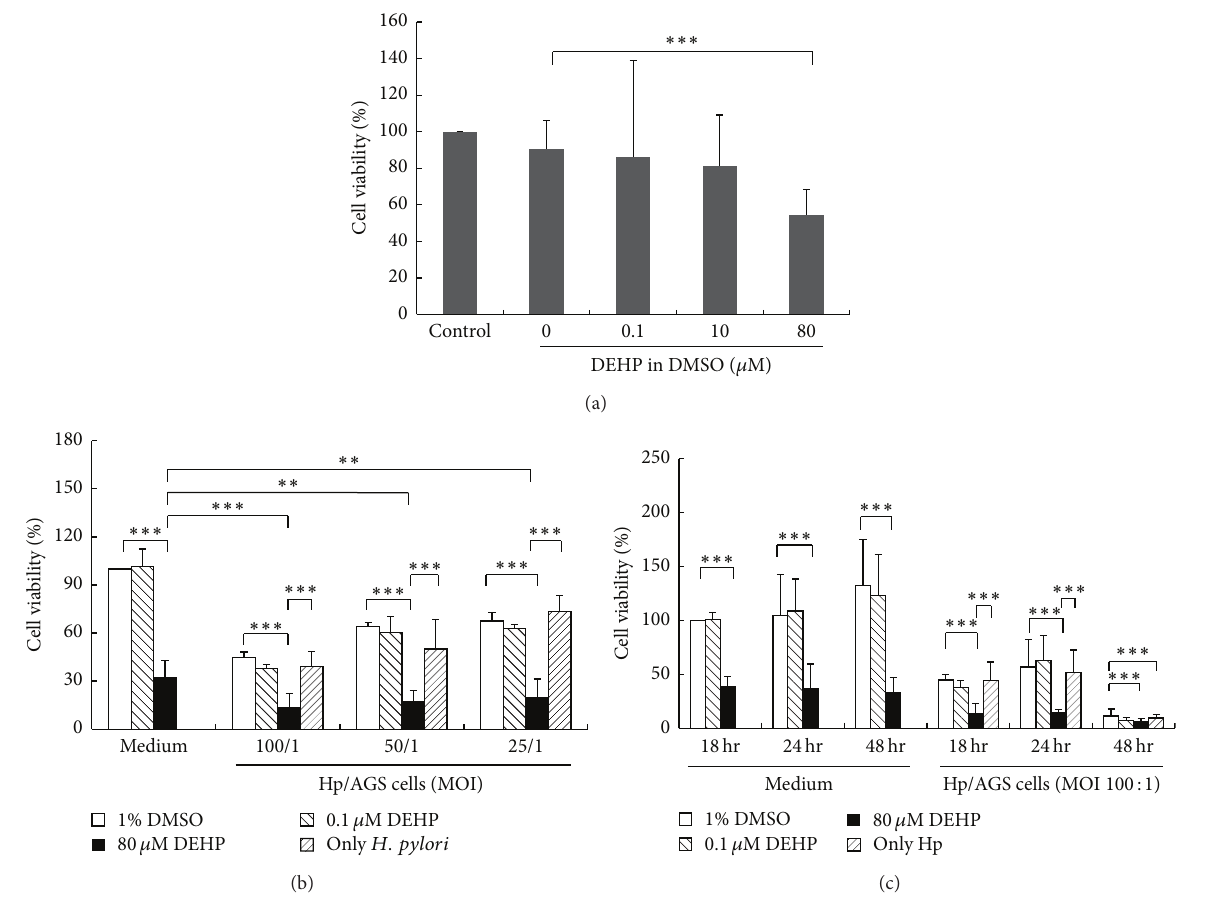
Figure 1: The cell viability of AGS cell. (a) Cells were treated with 0.1 to 80 𝜇 M DEHP for 24 hours. (b) Cells were treated 0.1 and 80 𝜇 M DEHP alone or combined with H. pylori (MOI = 100:1 ∼ 25:1) for 18 hours (ten independent experiments). (c) Cells were treated 0.1 and 80 𝜇 M DEHP alone or combined with H. pylori (MOI = 100:1) for 18, 24, and 48 hours Values obtained from MTT assay in mean + SD and normalized to nontreated value ( 𝑁 = 7 , three independent experiments, ∗∗ 𝑃 < 0.05 , ∗∗∗ 𝑃 < 0.01 , one way ANOVA assay with LSD post hoc